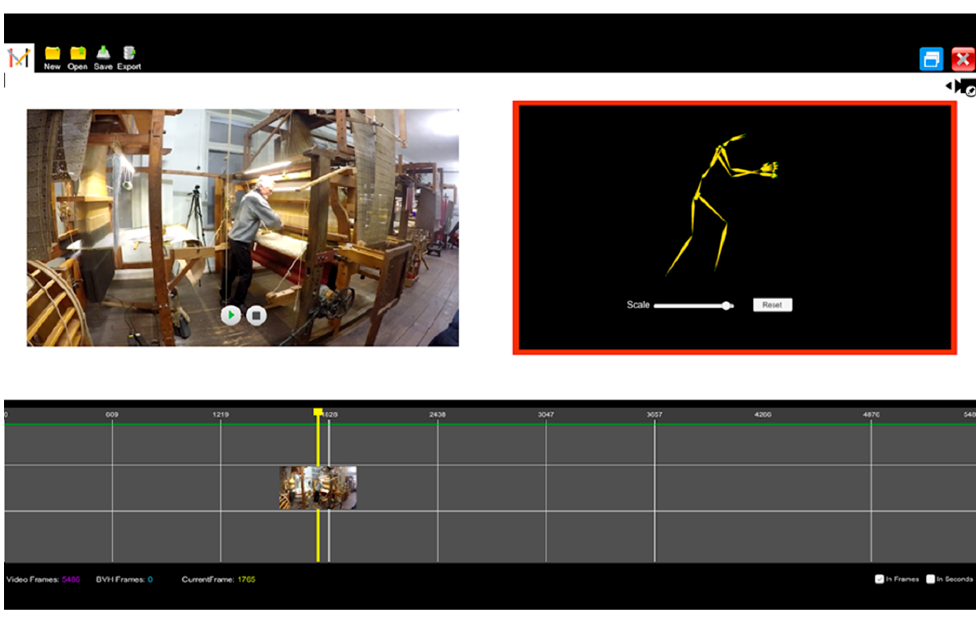
Figure 9. AnimIO, version 3.0.